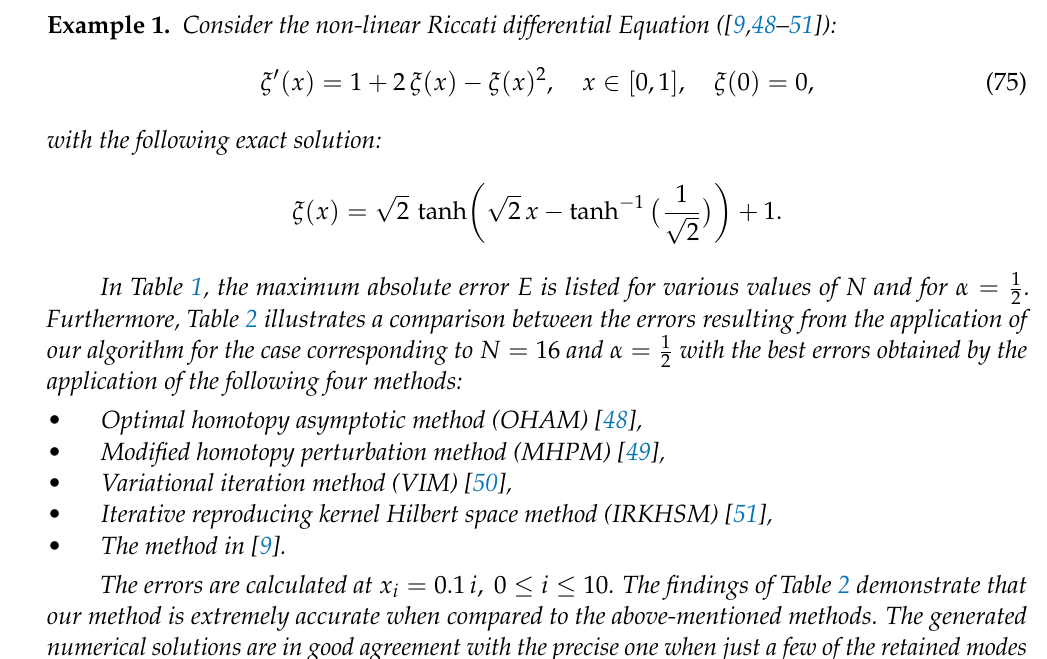
Table 1. Maximum absolute error E for Example 1 ( α = 1